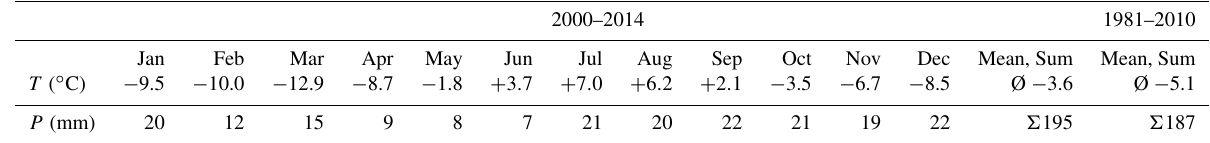
Table 2. Field data used (data: UNIS, NORPERM). Method Data Period Tinytag individual thermistor probes con- nected to miniature temperature loggers GeoPrecision thermistor string with data logger Delta-T profile